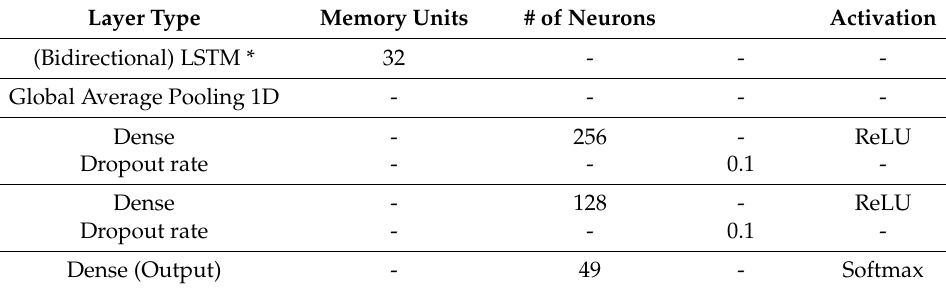
Table 2. LSTM and BiLSTM model